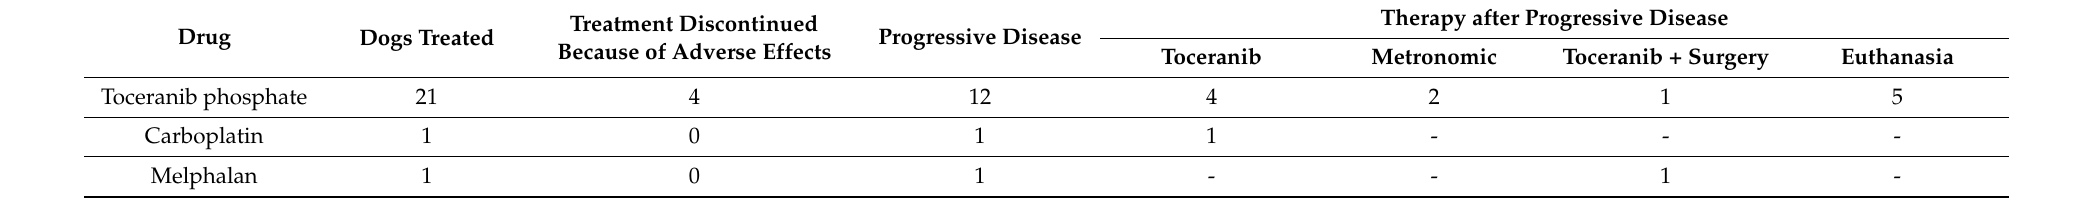
Table 1. Adjuvant treatments after the first surgical removal of AGASACA or in case of tumor